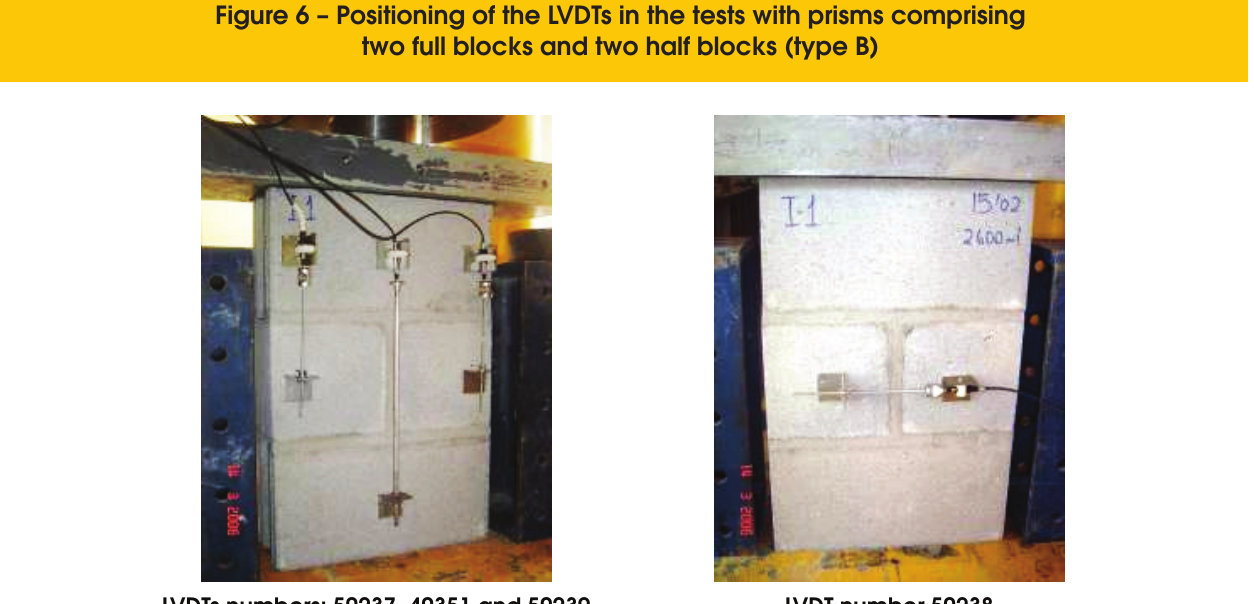
Figure 6 – Positioning of the LVDTs in the tests with prisms comprising two full blocks and two half blocks (type